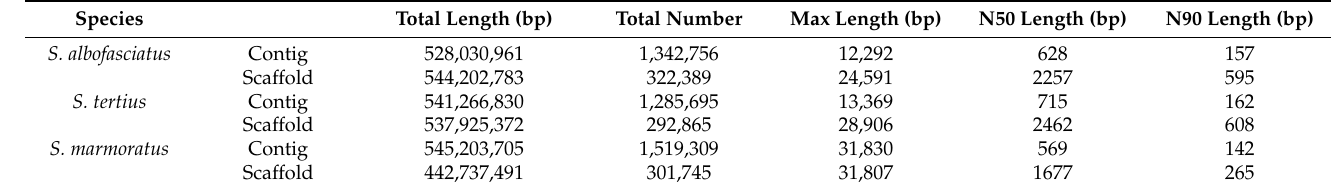
Table 3. Statistics of assembled draft genome